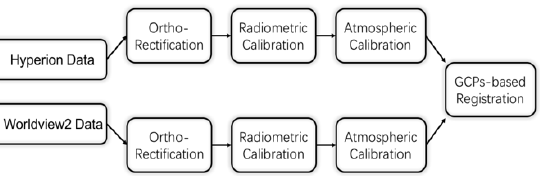
Fig. 1. Pre-processing of HSI and MSI data.